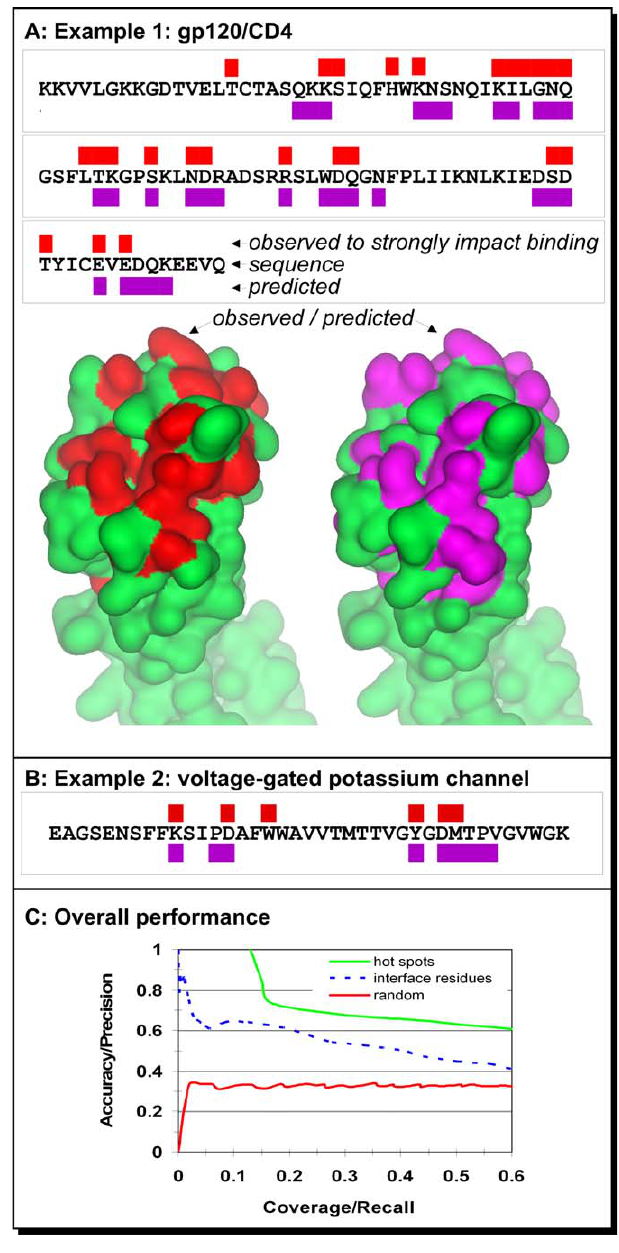
Figure 2. Accuracy of Prediction of Hotspots The ability to identify the residues that account for most of the energy of binding is assessed both on particular proteins and on a large dataset of alanine scans. (A) Alanine scans and predictions of essential interface residues in the V1 domain of CD4. The red rectangles (above sequence) mark positions that were shown to have significant effect on the affinity of the binding between CD4 to gp120 upon substitution to alanine [33]; the same residues are colored in red on the lower left surface representation of CD4 (PDB ID 1wiq_A). The green rectangles (below sequence) mark positions predicted to participate in a protein–protein interaction; these residues are also colored in violet on the lower right. Note that five of the residues predicted in interfaces were not mutated in the alanine scan. Thus, we cannot evaluate their correctness and left them out of this analysis. (B) Hotspots experimentally observed and predicted for the shaker voltage-gated potassium channel. All predictions and experimental substitutions [34] for this stretch are reported in this figure. (C) Accuracy versus coverage in predicting hotspots and interface residues. The performance of ISIS (green) and random assignment